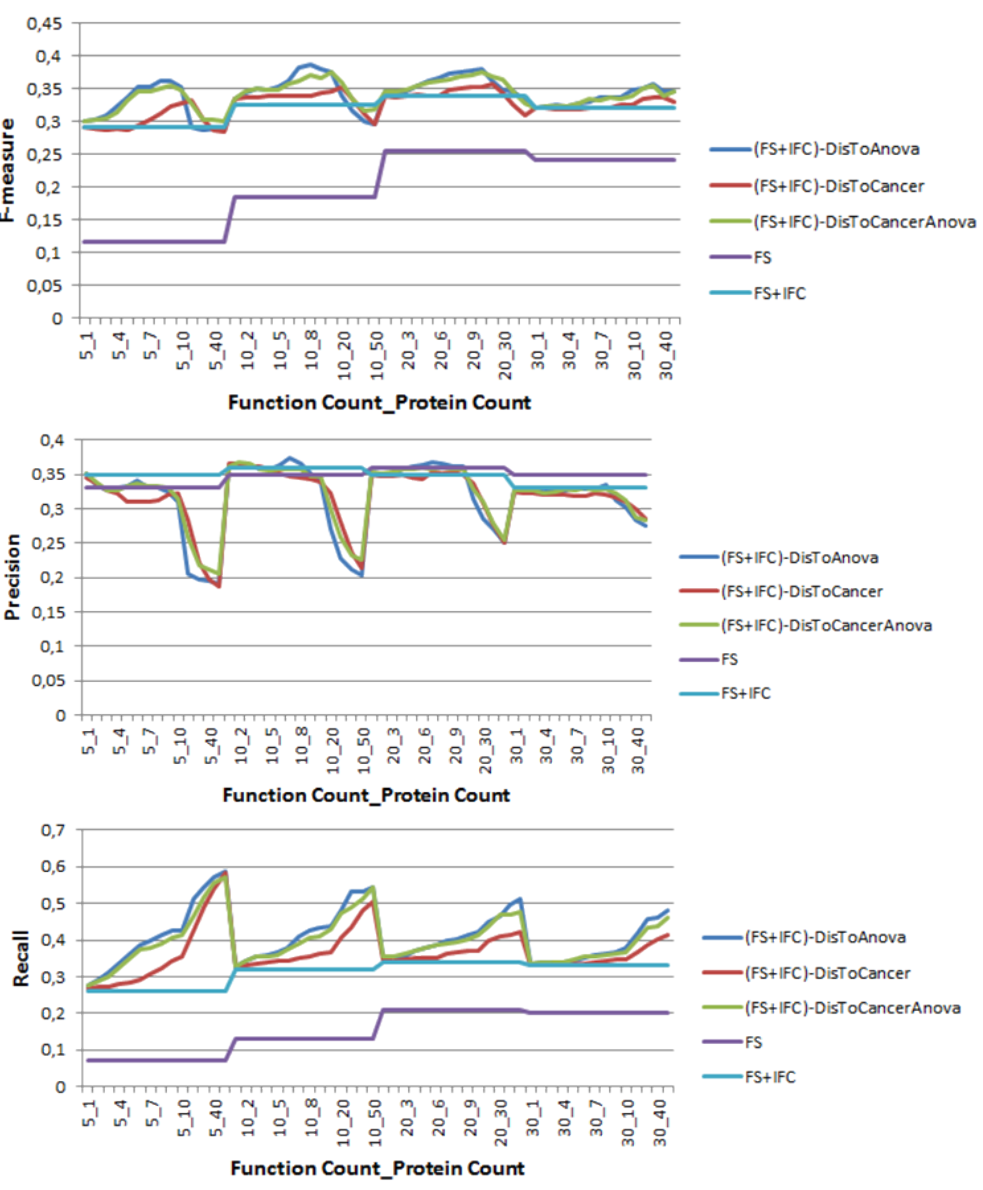
Figure 4: Comparing different integrated methods. Comparing to functional and structural context methods, the integrated method gives rise to more cases (17 out of 52 in ( FS + IFC ) - DisToCancerAnova, as opposed to 0 out of 52 in FS + IFC ) with F-measure over 35% (and up to 39% in one